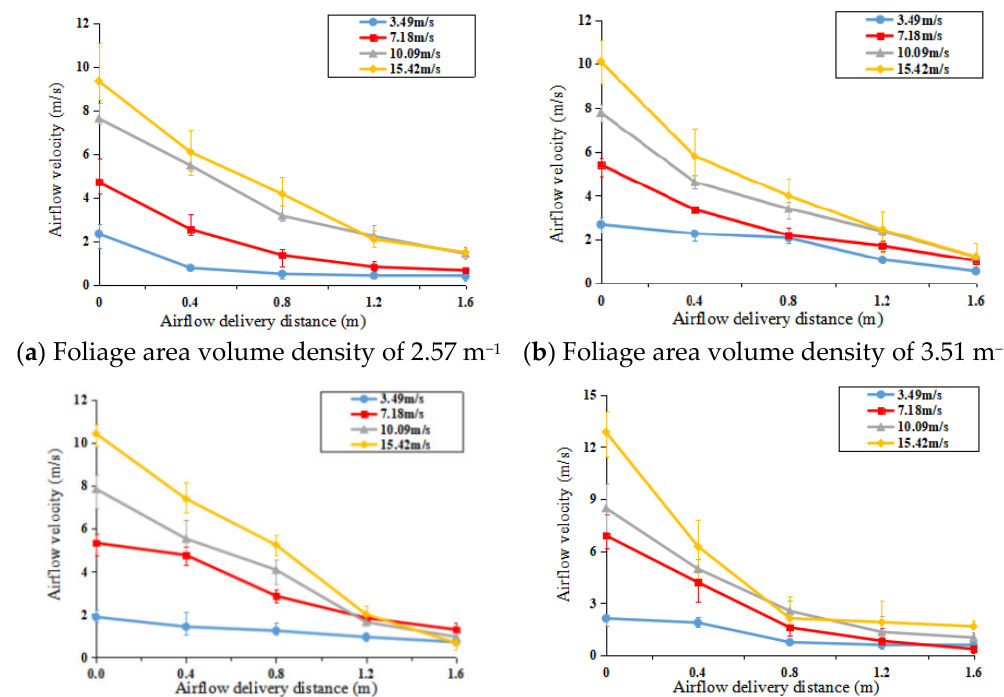
Figure 12. Canopy airflow attenuation characteristics for different leaf area volume densities.